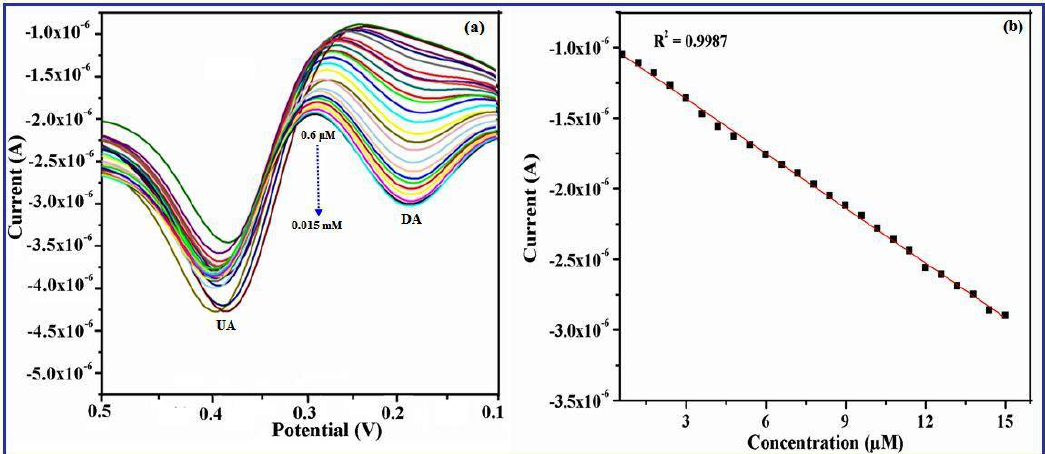
Figure 11. DPV current responses of γ -Fe 2 O 3 nanobelts/GCE obtained in 0.1 M PBS (pH 7.4). ( a ) Various concentration of DA varied linearly from 0.6 µ M to 0.015 mM in the presence of 0.1 mM UA. ( b ) Calibrations curve of DA plotted versus oxidation current and concentration of